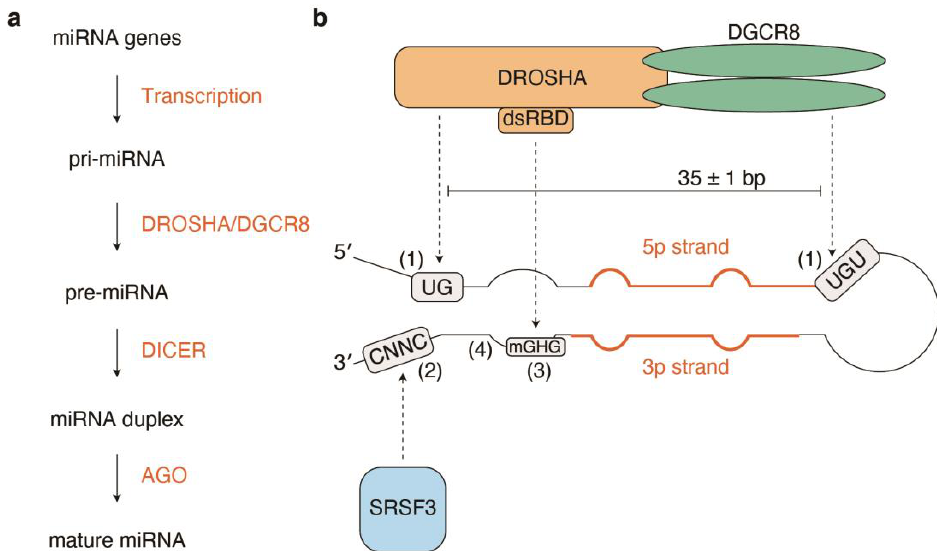
Figure 1. Structural basis of efficient pri-miRNA processing. ( a ) Outline of the canonical miRNA biogenesis. ( b ) The structure of pri-miRNA and related molecules are demonstrated. The numbers in parentheses indicate the features of the miRNA precursor sequences contributing to efficient pri- miRNA processing. (1) UG and UGU motifs are recognized by DROSHA and DGCR8, respectively. Thus, the DROSHA–DGCR8 complex contributes to the correct measurement of the miRNA basal stem length. (2) A CNNF motif is bound by SRSF3. SRSF3s have multifaceted roles in miRNA processing by facilitating pri-miRNA processing efficiency, modulating alternative processing, and preventing 5p-nick processing and inverse processing. (3) An mGHG motif is bound by the dsRBD of DROSHA and helps DROSHA identify the miRNA cleavage site. (4) The large-sized asymmetric internal loops, i.e., large-sized mismatches, inhibit the cleavage of the 3p strand and therefore downregulate miRNA expression. Pri-miRNA, primary miRNA; mGHG, mismatched GHG; dsRBD, double-stranded RNA binding